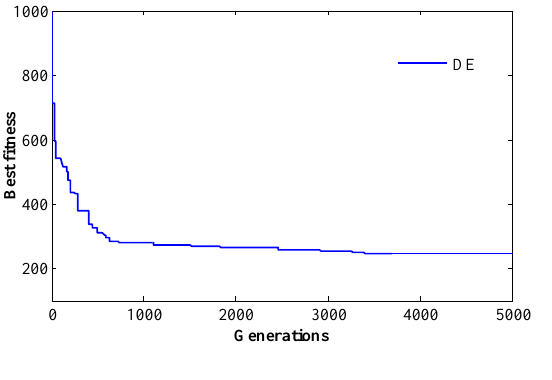
Figure 7: Convergence curve of Differential Evolution Al- gorithm